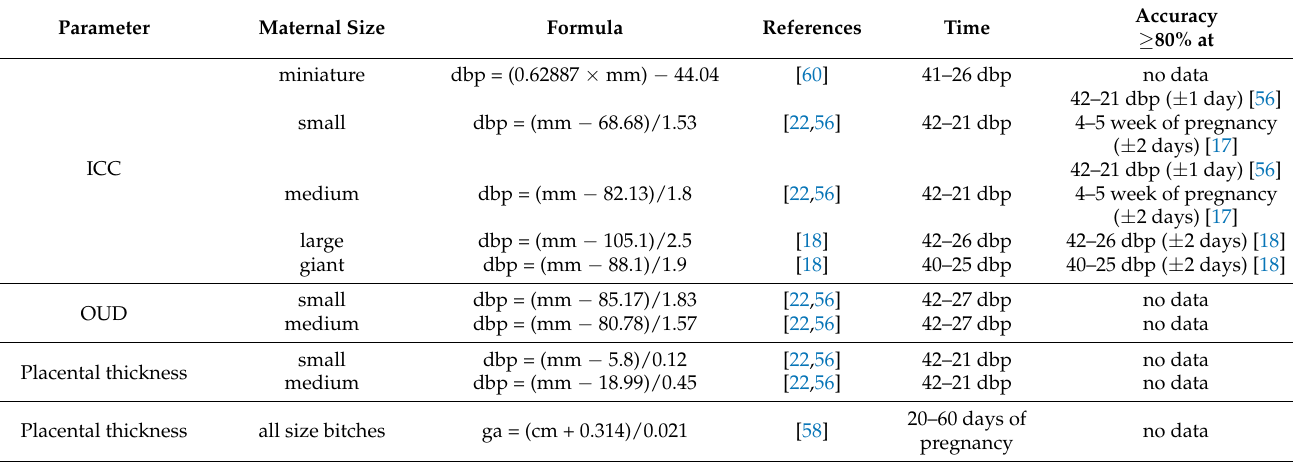
Table 3. Formulas for calculations of days before parturition (dbp) or gestational age (ga: days after LH peak) in bitches of different size (miniature ≤ 5 kg, small ≤ 10 kg, medium 11 to 25 kg, large 26 to 40 kg, and giant > 40 kg [16,18,59]) for inner chorionic cavity (ICC), outer uterine diameter (OUD) and placental thickness. The measurements (scale either in mm or cm) are the mean of ICC and OUD orthogonal measurements in all measured fetuses. References are reported in brackets. Time of measurement refers to the dbp or days of pregnancy at which each parameter was calculated. When available, dbp or week of pregnancy in which accuracy was ≥ 80% ( ± 1 or ± 2 days) is also